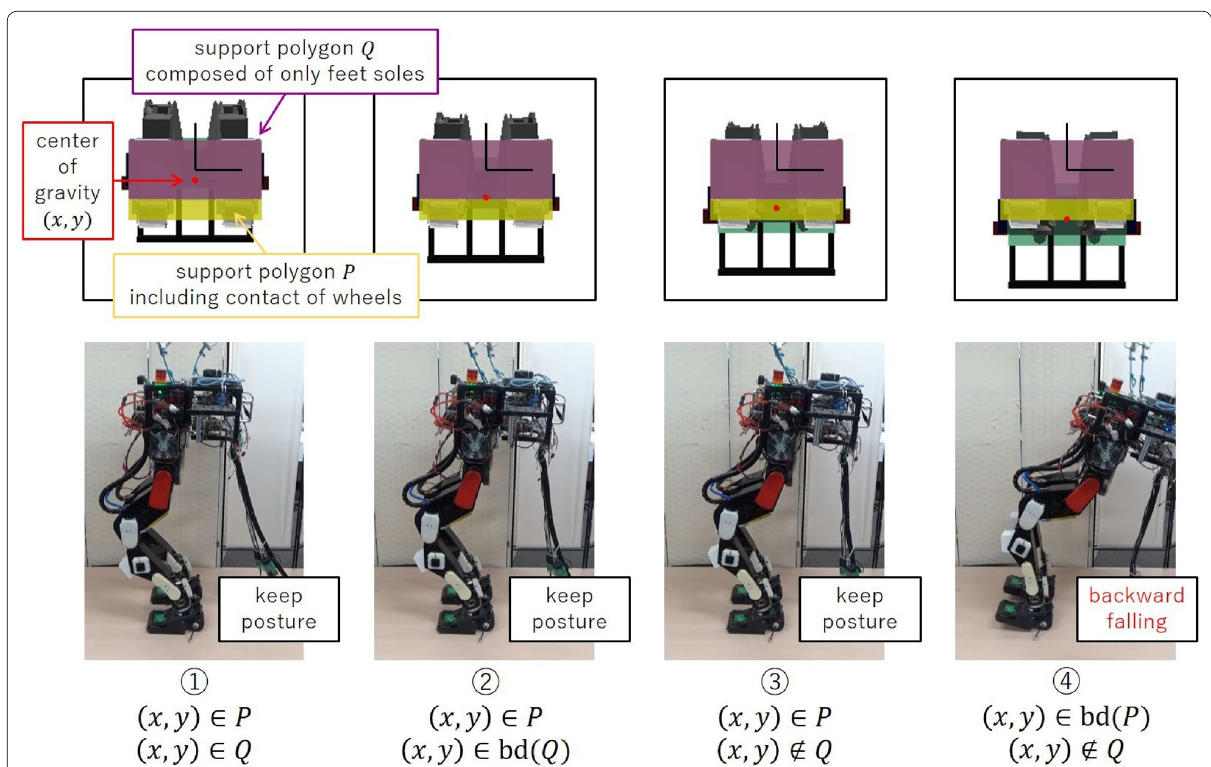
Fig. 4 Comparison of support polygon P including contact of wheels and support polygon Q composed of only feet soles when center of gravity ( x , y ) of robot moves posterior to stance